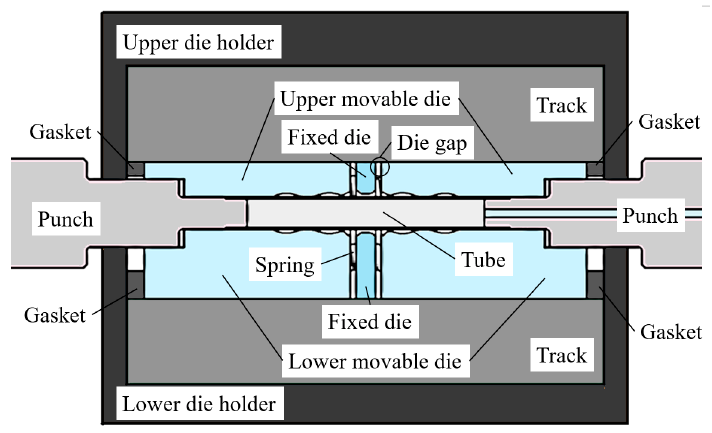
Figure 13. Completed lower part of movable die set for hydroforming experiments. Figure 12. Geometric configurations of self-designed movable die sets. Figure 12. Geometric configurations of self-designed movable die sets. Metals 2020 , 10 , x FOR PEER REVIEW